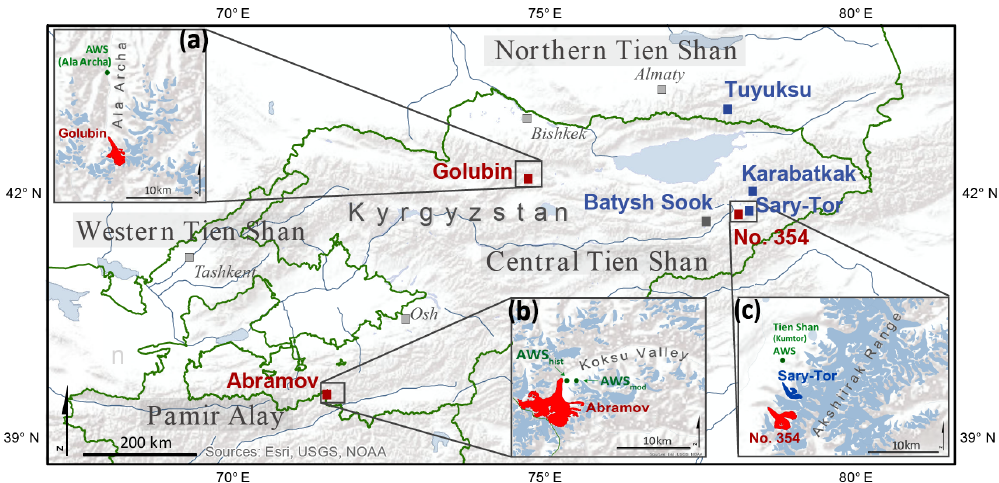
Figure 1. Overview map of central Asia showing the location of glaciers (blue) with available long-term SMB measurements. Glaciers investigated in this study are marked in red. The insets show the position of the automatic weather station (AWS) for (a) Golubin, (b) Abramov and (c) Glacier no. 354. Note that AWS mod indicates the position of the new AWS installed in 2011 and AWS hist the old glaciological station at